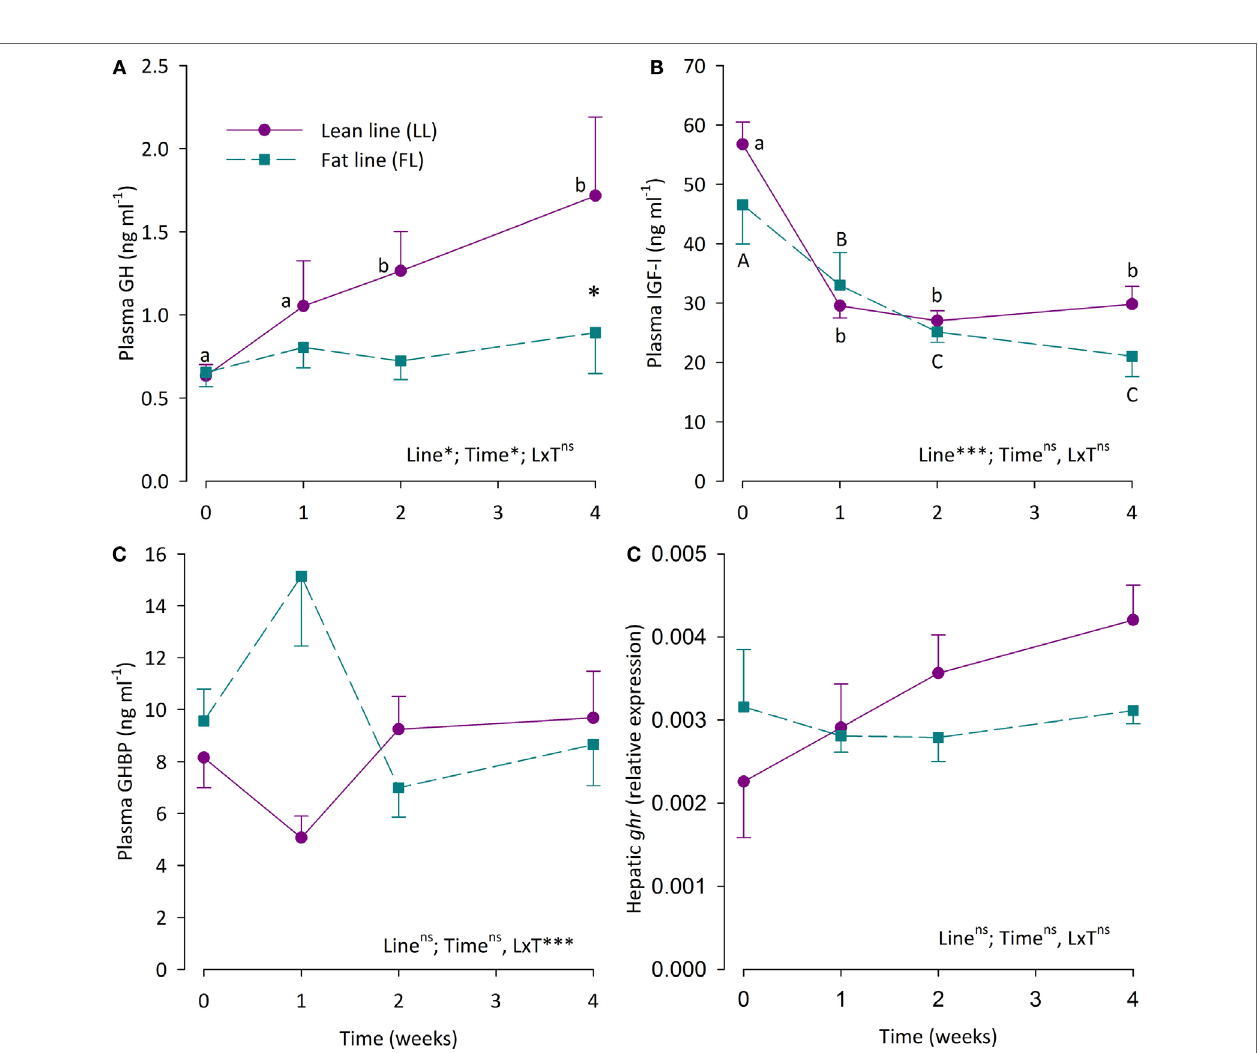
FigUre 2 | (a) Plasma growth hormone (GH) levels, (B) plasma insulin-like growth factor I (IGF-I) levels, (c) plasma growth hormone-binding protein (GHBP) levels, and (D) hepatic expression of the growth hormone receptor gene 2a ( ghr2a ) in fat line (FL, ◼ ) and lean line (LL, ⚫ ) rainbow trout over a 4-week fasting period. Data are presented as means ± SEM. Two-way ANOVA results on main effects (strain and time) as well as the interaction between the main effects (S × T) are indicated in the panels as being non-significant (ns, p > 0.05) or significant at the levels of * p < 0.05, or *** p < 0.001. Post hoc analysis was carried out if main effects were significant. For “Strain,” differences are indicated as * p < 0.05. For “Time,” significant differences are indicated by different letters, lower case for LL fish and upper case for FL fish.